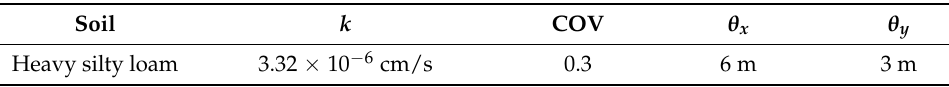
Table 1. Parameters of embankment model.